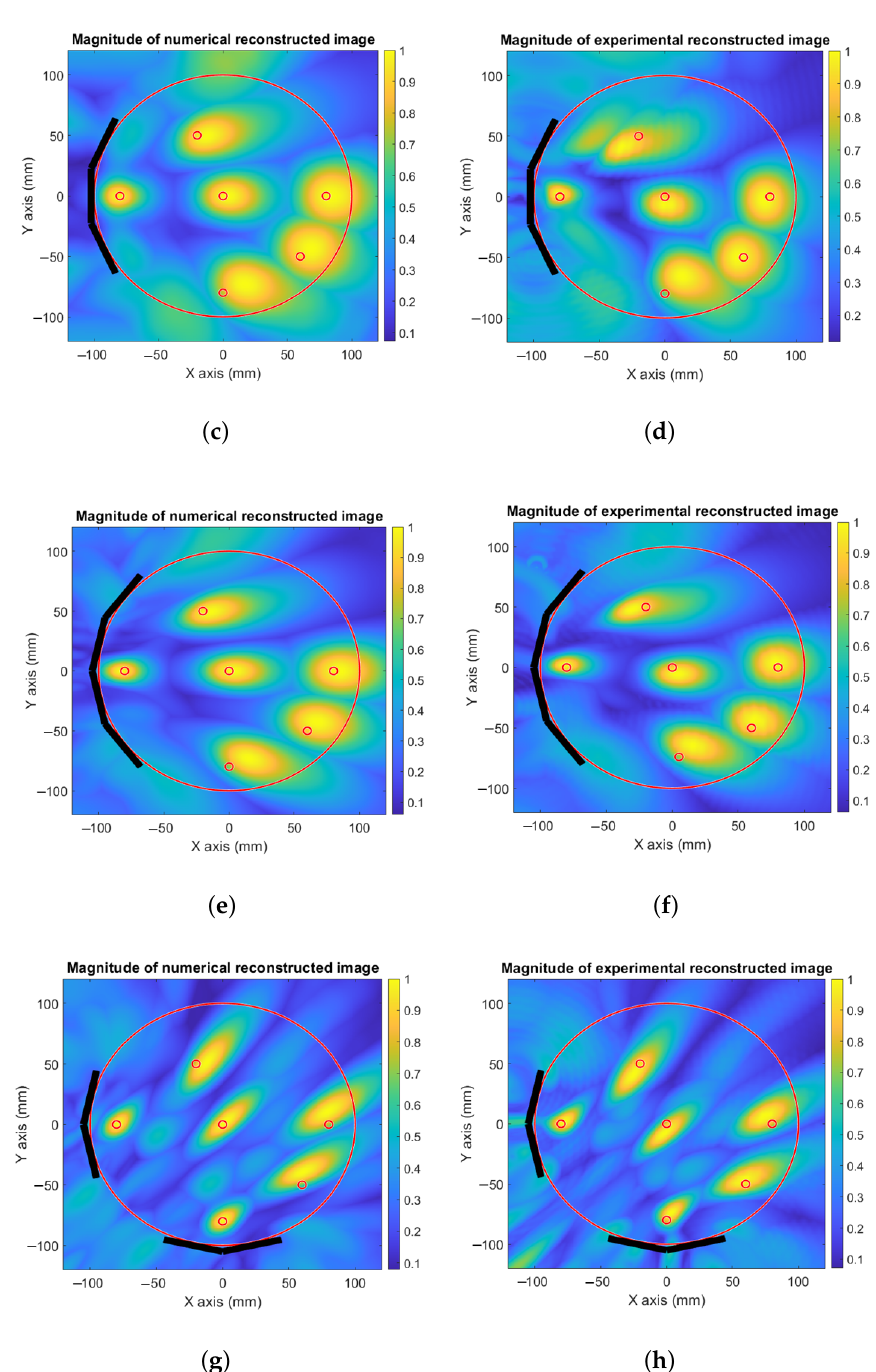
Figure 7. Numerical and experimental image reconstruction of optimized setups. ( a ) Simulated image using a system based on two probes. ( b ) Measured image using a system based on two probes. ( c ) Simulated image using a system based on three probes. ( d ) Measured image using a system based on three probes. ( e ) Simulated image using a system based on four probes. ( f ) Measured image using a system based on four probes. ( g ) Simulated image using a system based on the orthogonal set of two UWB antennas. ( h ) Measured image using a system based on the orthogonal set of two UWB